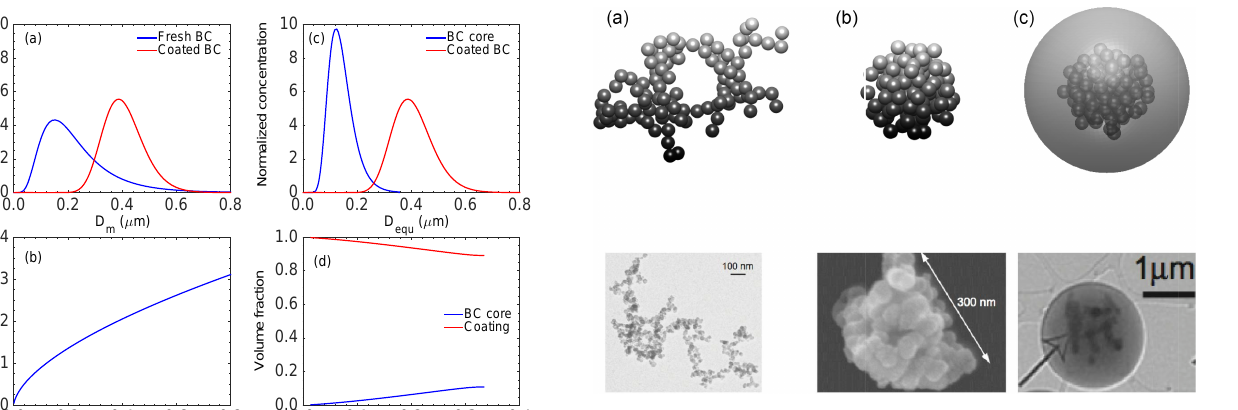
Figure 3. Geometries of numerically generated BC aggregates with different particle geometries, i.e., loose aggregate (a) for fresh BC, compact aggregate (b) for compact BC, and coated aggregate (c) for coated BC, and some examples of realistic BC images for com- parison (Burr et al., 2012; Lewis et al., 2009; Freney et al., 2010). Again, the monomer diameters are assumed to be 30nm. A fractal dimension of 1.8 is assumed for the fresh BC, and 2.8 is used for the compact and coated BC